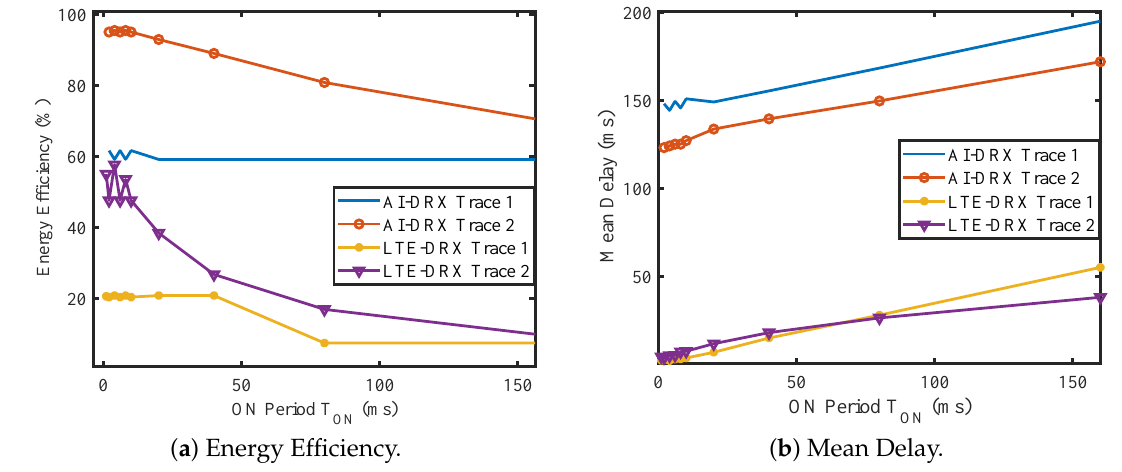
Figure 10. AI-DRX energy efficiency and mean delay with varying T ON ( Th Min = 20, Th Max = 100).